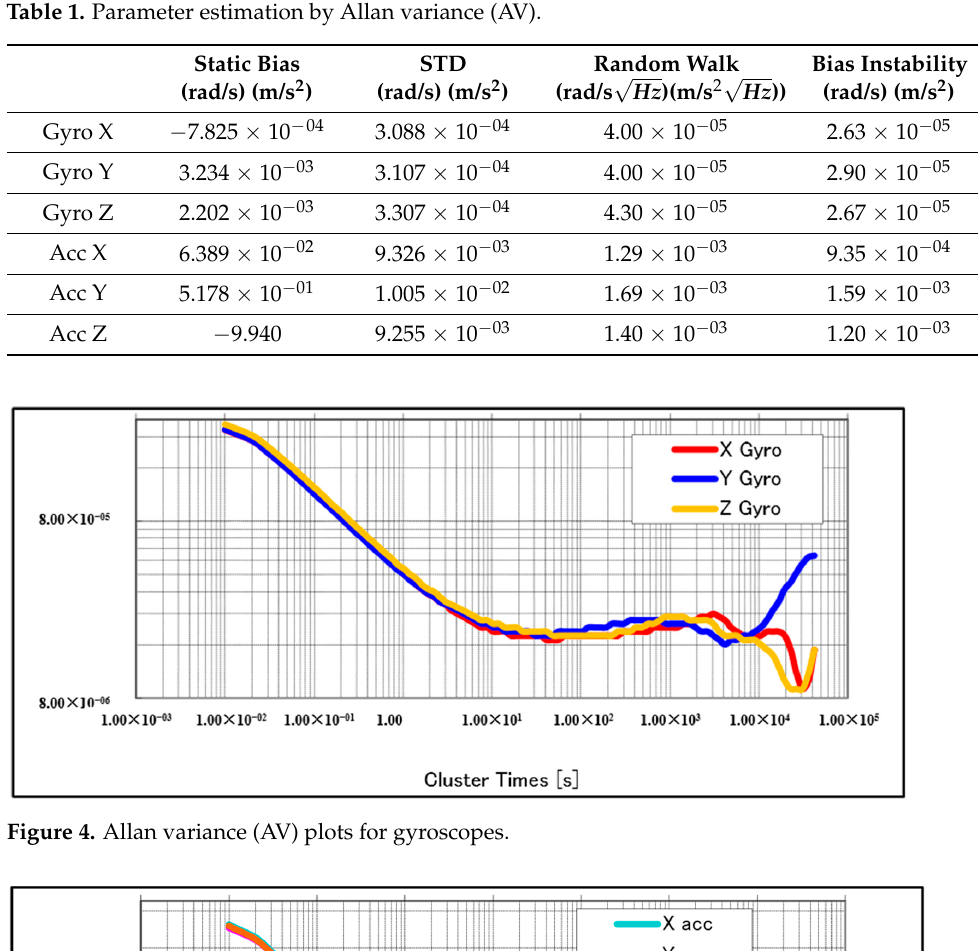
8 of 21 Figure 3. Loosely coupled INS/DVL EKF integration architecture.